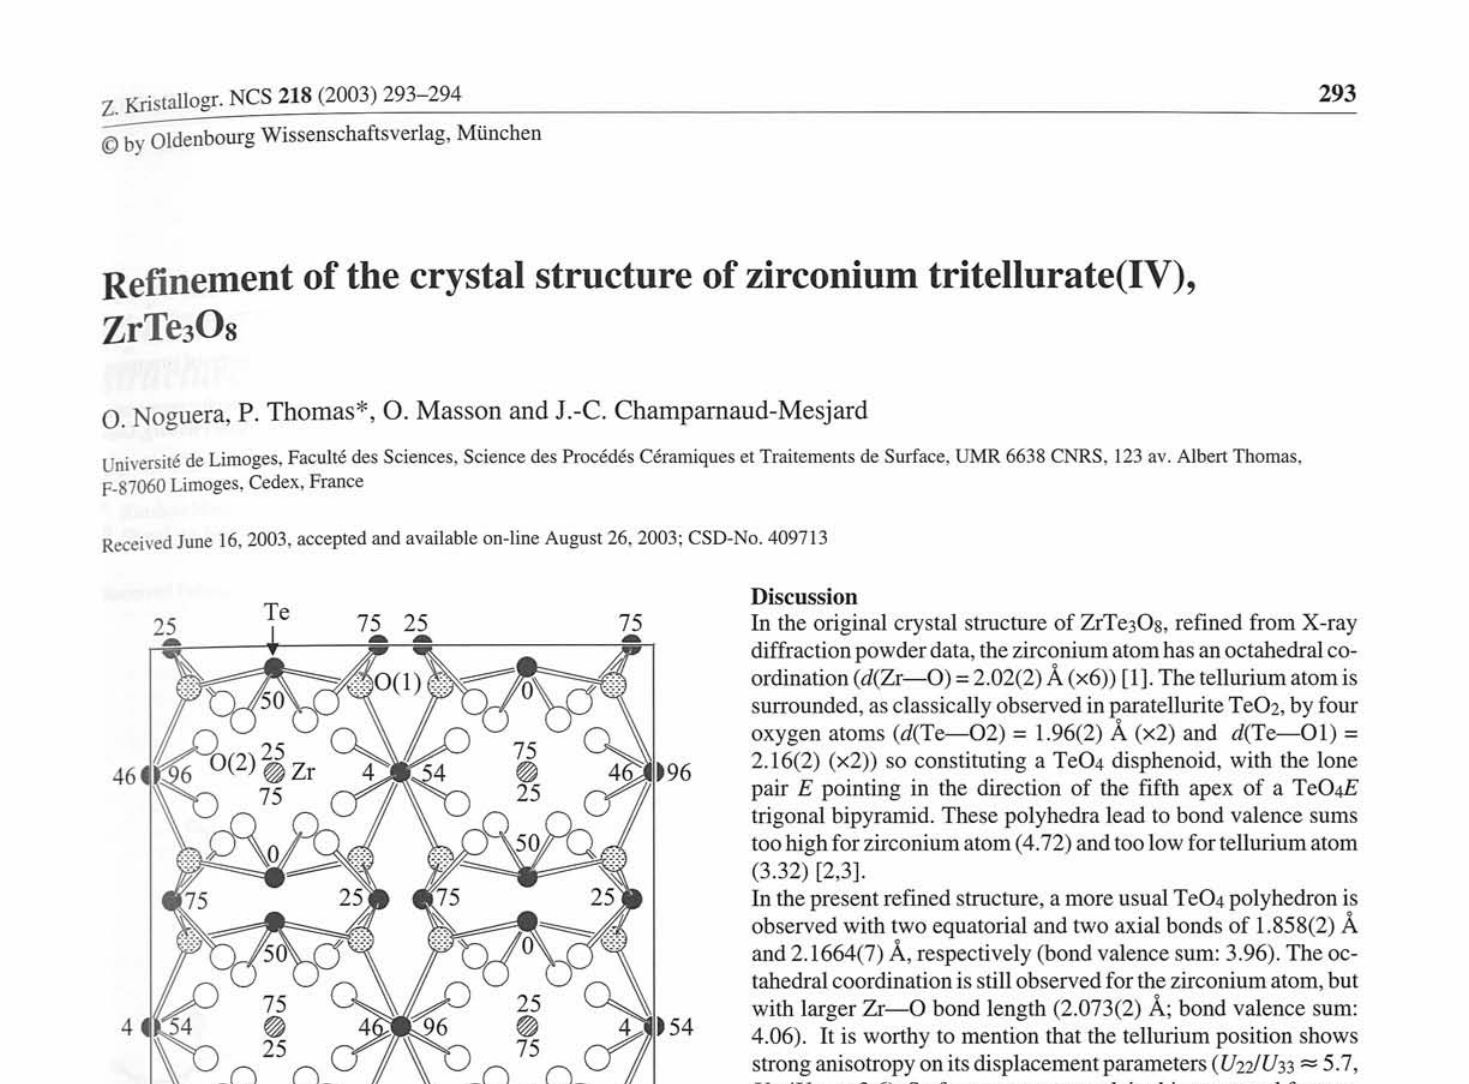
Table 1. Data collection and handling.